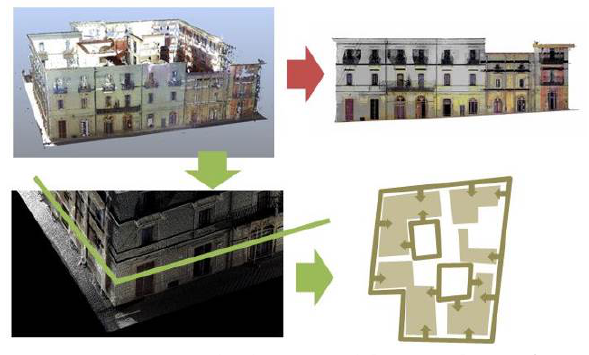
Figure 12. From the discrete model. Extrapolation of orthophoto for the restitution of 2D drawings and sllices for the assembly of the direct interior survey (software: Scene).